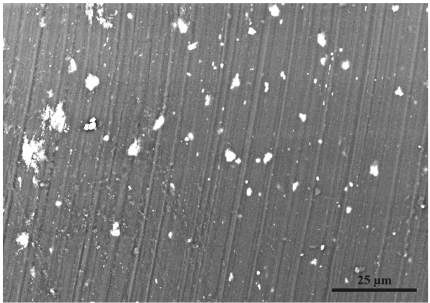
Figure 5: Scanning electron micrograph of a filament specimen of PLA loaded with P-glass at a loading of 15% by weight.